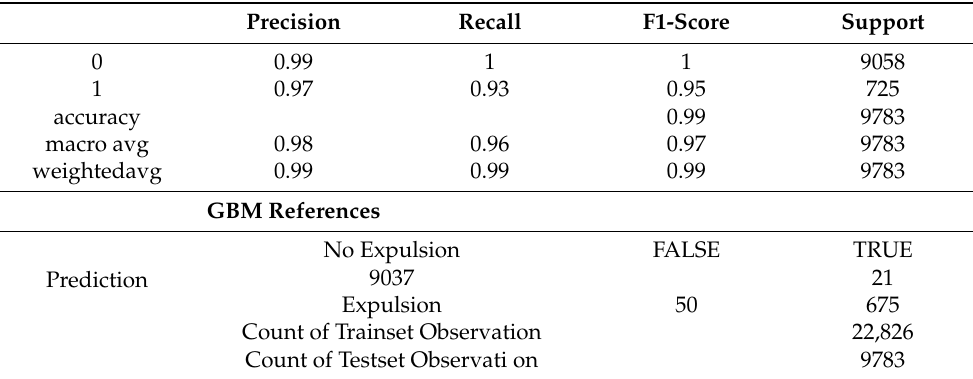
Table 11. Confusion matrix for